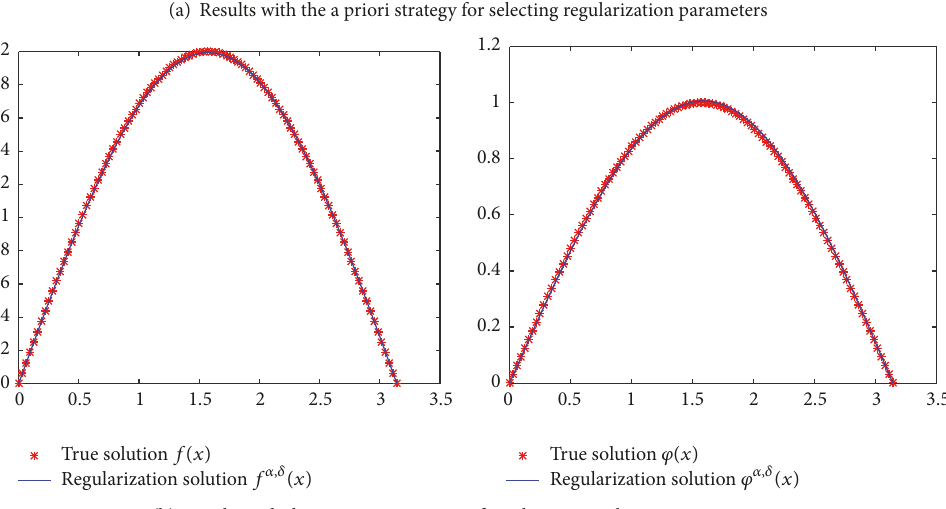
(b) Results with the a posteriori strategy for selecting regularization parameters Figure 2: Behaviors of the true and the regularization solution when 𝜌 = 0.10 . Table 2: Numerical results of Example